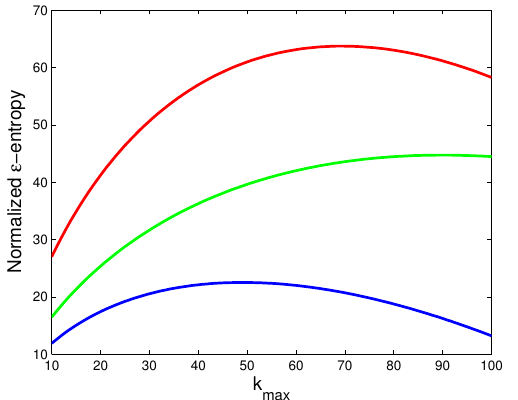
Figure 9: A comparison between the normalized upper bounds of the (cid:15) -entropy associated to the three different configurations ,as k max varies in the interval [10 , 100] m − 1 , when M = 3 . The blue line refers to single view /single fre- quency configuration, the red and green line to multi-view and multi-frequency configuration, respectively